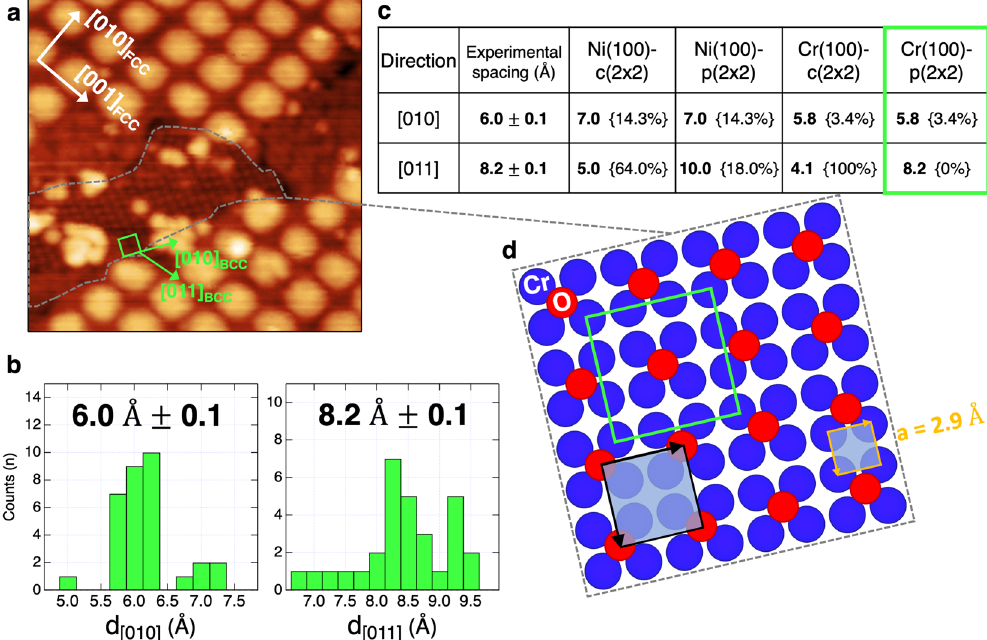
Fig. 4 Cr phase segregation. a Topography image after the 18 L oxidation step (20 × 20 nm 2 ). This oxidation step illustrates the segregation of Cr(100) and the FCC and BCC surface orientations are marked in the image, where the FCC directions are deduced from the NiO orientation relative to Ni as shown previously. The distributions in ( b ) give the maximum-maximum spacing along the [010] BCC and [011] BCC directions, respectively, with the average spacing given in each histogram. c Compares the surface geometry measured in the STM images to other surface structures known for Ni(100) and Cr(100) for various oxygen coverages. The table summarizes the surface dimensions and interatomic spacing with the {discrepancy} to the experimental data given for each structure model. d Model of the Cr(100) surface for the Cr(100)-p(2 × 2) phase, which has an excellent agreement with the experimental data. The STM topography image was taken at V bias = − 3.0 V, I t = 0.1